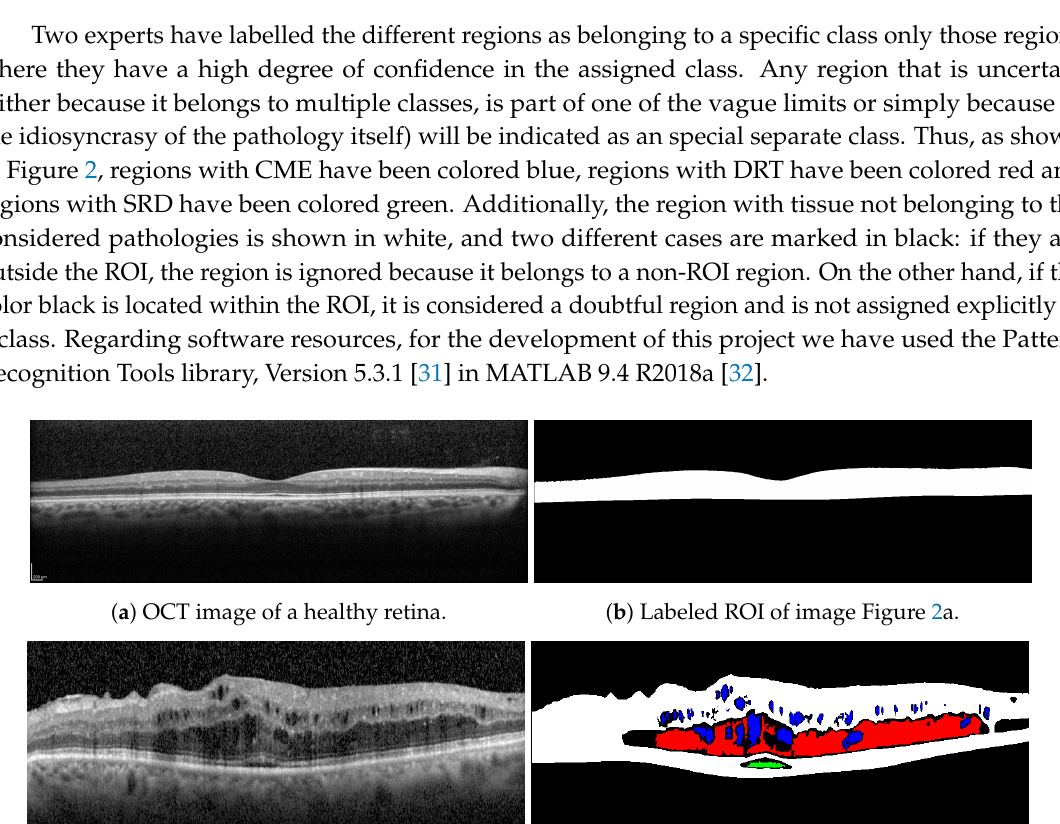
( a ) OCT image of a healthy retina. ( b ) Labeled ROI of image Figure 2a.